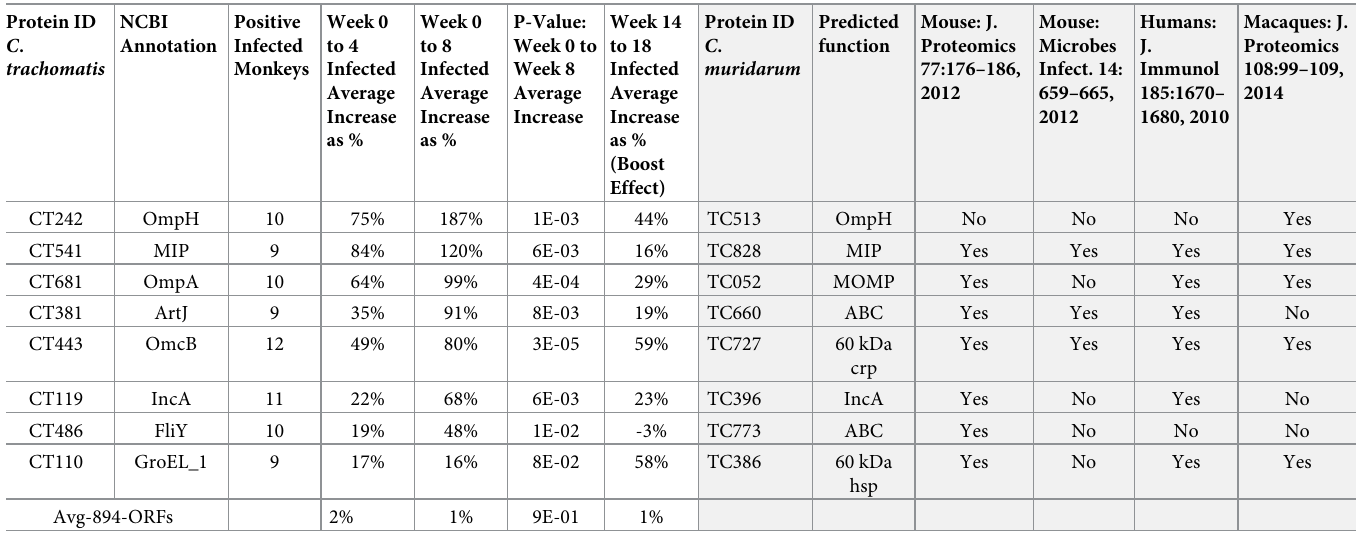
Table 1. Immunodominant antigens.